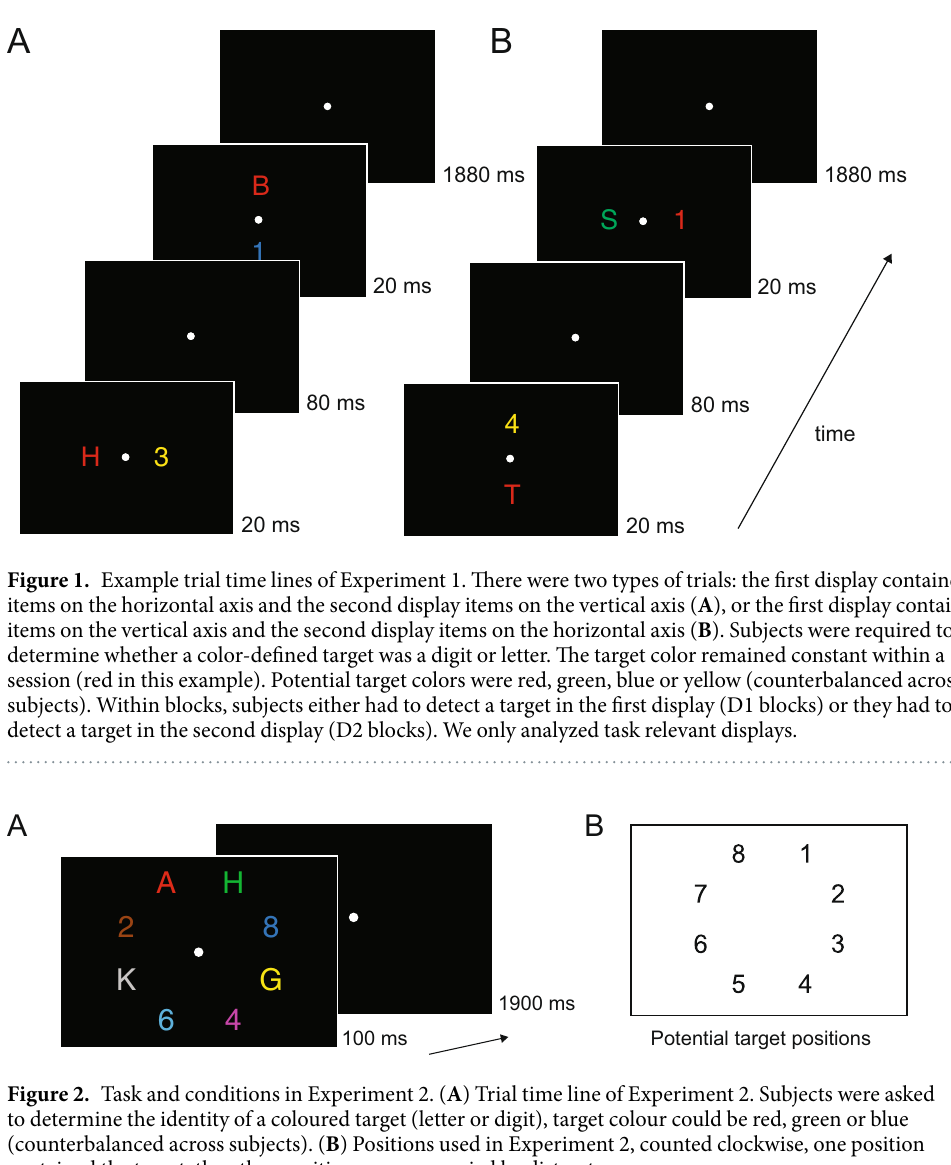
analyses. Backward decoding models (BDMs) predict which stimulus condition (e.g., an attended target at a par- ticular location) was present on the basis of EEG activity patterns. Above-chance classification accuracy then shows that the relevant information is represented in EEG signals, and the time course of classification per- formance indicates at which post-stimulus latency this information becomes available. BDM classifier outputs can also be used to construct maps showing the topography of the neural activity underlying successful classi- fications 11 . Forward encoding models (FEMs) reverse this direction of inference by describing the relationship between multivariate neural activity and an experimental variable that is hypothesized to be continuous in nature (here the attended location). The relationship between this variable and the multivariate signal can be described using a Channel Tuning Function (CTF) 12, 13 . For example, multivariate analyses of alpha-band EEG activity have recently been employed to track the coding of spatial locations in working memory 14 and during endogenously cued spatial attention shifts 15 . Here, we applied both BDMs and FEMs to raw EEG signals to extract and recon- struct feature-based target selection processes in space and in time. In Experiment 1, colour-defined targets appeared on the horizontal or vertical midline in two successive dis- plays (Fig. 1). Both horizontal and vertical target positions were successfully classified using BDMs from around 200 ms after display onset, and with topographies consistent with the retinotopic architecture of early visual cortex. In Experiment 2, targets could appear at eight locations, but never on the vertical or horizontal mid- line (Fig. 2). Forward modelling yielded Gaussian-shaped Channel Tuning Functions (CTFs), which we used to construct hypothetical channel responses and activation maps for targets placed on the horizontal and vertical midline. The resulting maps were then validated through the topographies observed in Experiment 1 (where